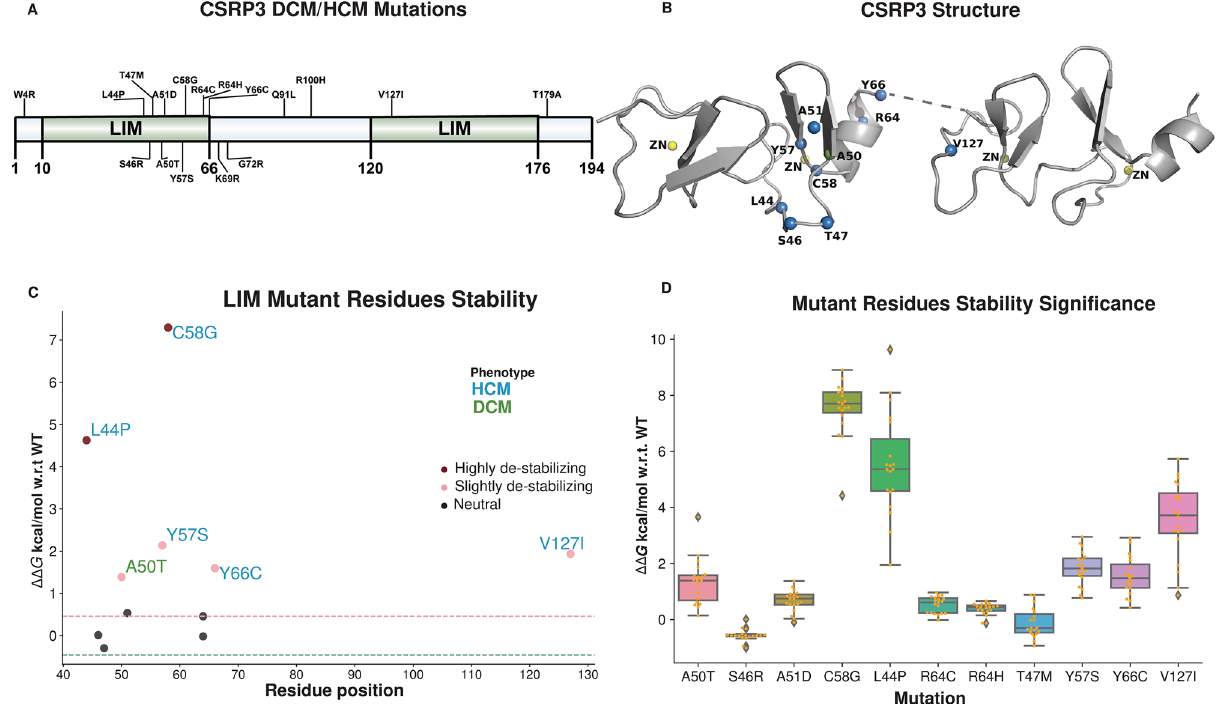
Figure 1. CSRP3 HCM/DCM mutations. ( A ) CSRP3 LIM domains length and mutations mapped to the full protein shows localisation of mutations to the LIM domains. ( B ) NMR structures of LIMs and mutations mapped on them (blue color spheres) using PDB ID: 2O10 for LIM1 and PDB ID: 2O13 for LIM2. ( C ) Structural stability analysis of LIM domain HCM (blue color) and DCM (green color) mutations. Severity of mutations are indicated by shades of red color (dark red and pink). Neutral mutations are shown as black. Dotted red and green lines depict the threshold for deciding destabilising and stabilising mutations. ( D ) Bar plot highlighting the mutational stability of CSRP3 LIM domains. The plot shows the significance of these mutations on ensemble of 19 and 20 NMR conformers of LIM1 and LIM2 domains,